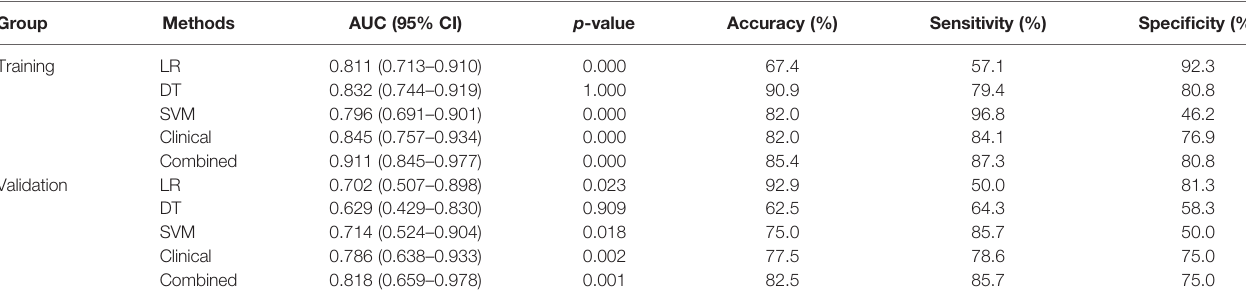
TABLE 3 | The performance of radiomics model using LR, DT, and SVM, clinical model and combined model. Group